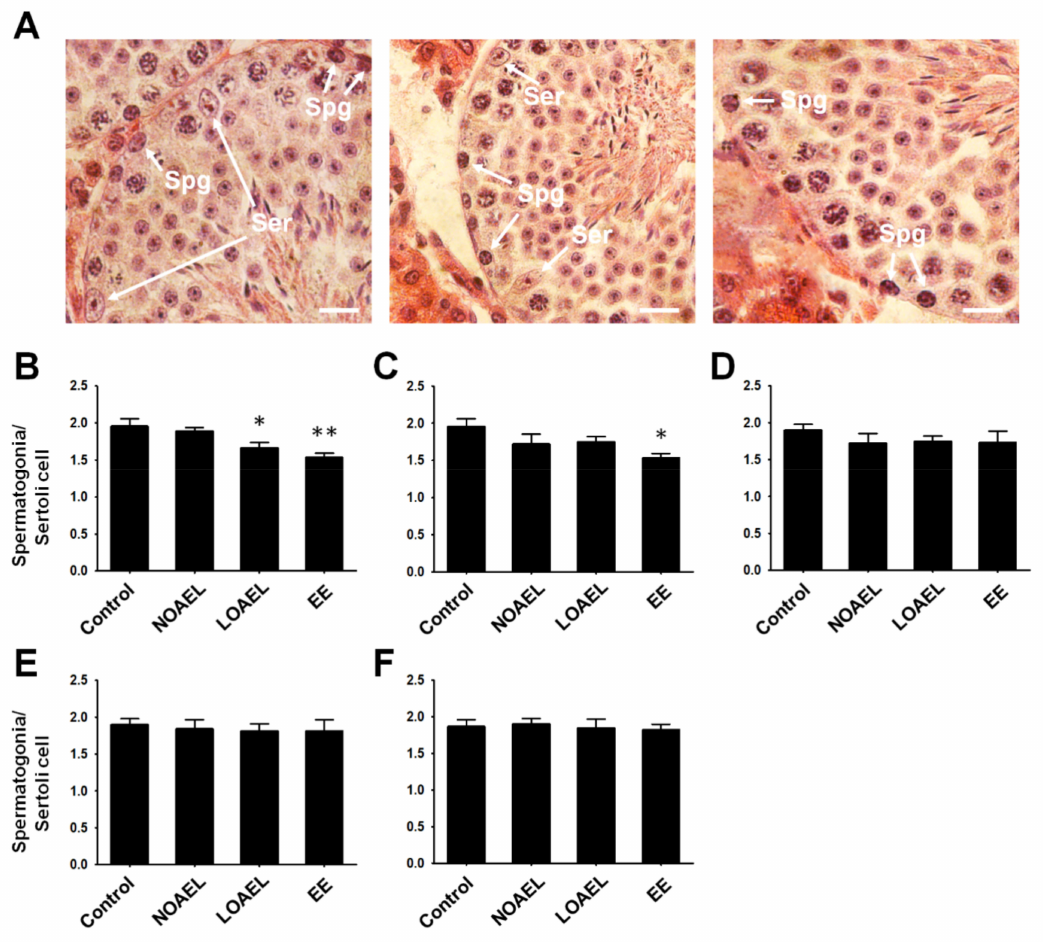
Figure 4. Ratio of spermatogonia and Sertoli cells. Ratios were measured as the total number of spermatogonia per Sertoli cell of the same seminiferous epithelium (SE). ( A ) Testicular cross sections showing SE containing spermatogonia (spg). Scale bar = 10 µ m. Ratios of spermatogonia and Sertoli cells (ser) from ( B ) exposed group (F0) ( n = 6 mice / group), ( C ) F1 generation ( n = 6 mice / group), ( D ) F2 generation ( n = 6 mice / group), ( E ) F3 generation ( n = 6 mice / group), and ( F ) F4 generation ( n = 6 mice / group). Statistical analysis of the di ff erence between exposed and control groups was performed using one-way analysis of variance (ANOVA) (* p < 0.05 and ** p < 0.01